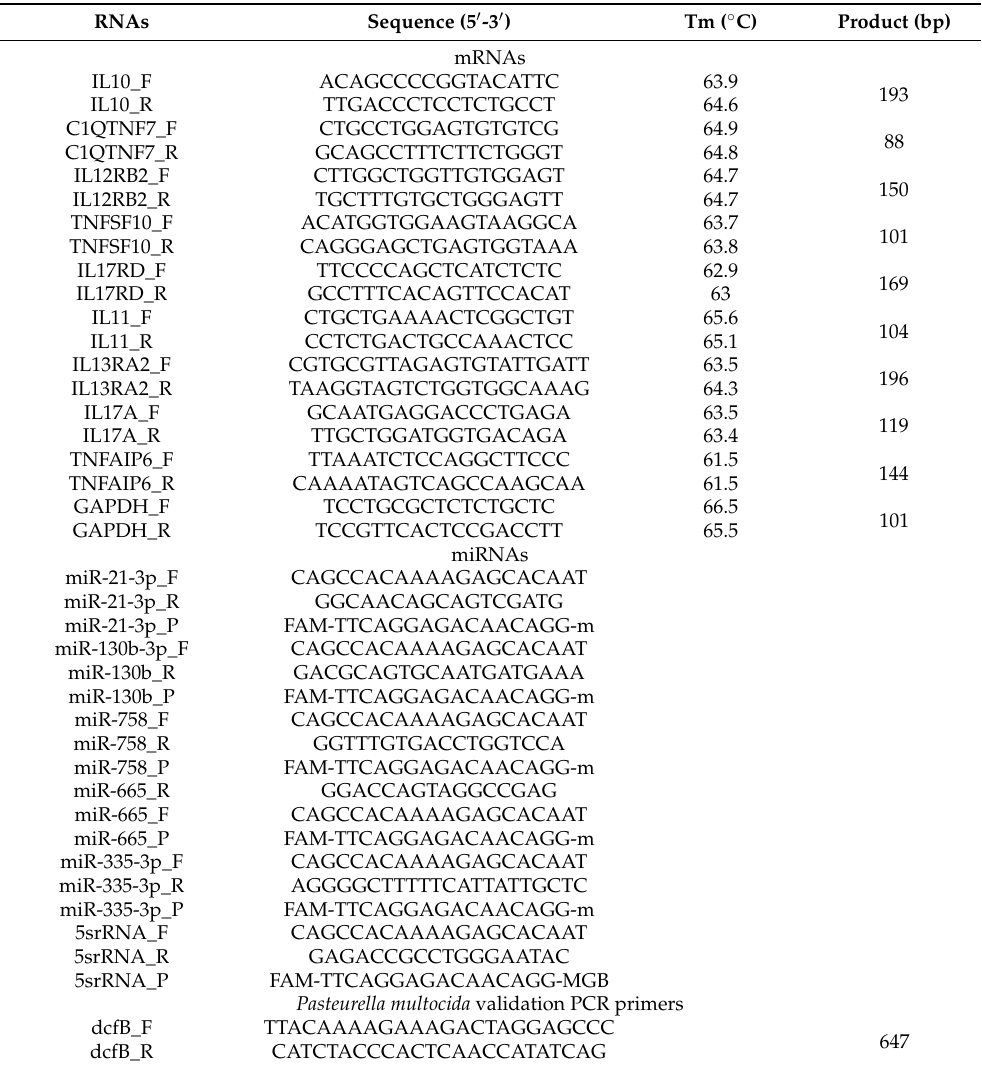
Table A1. Primers used for qPCR analyses.